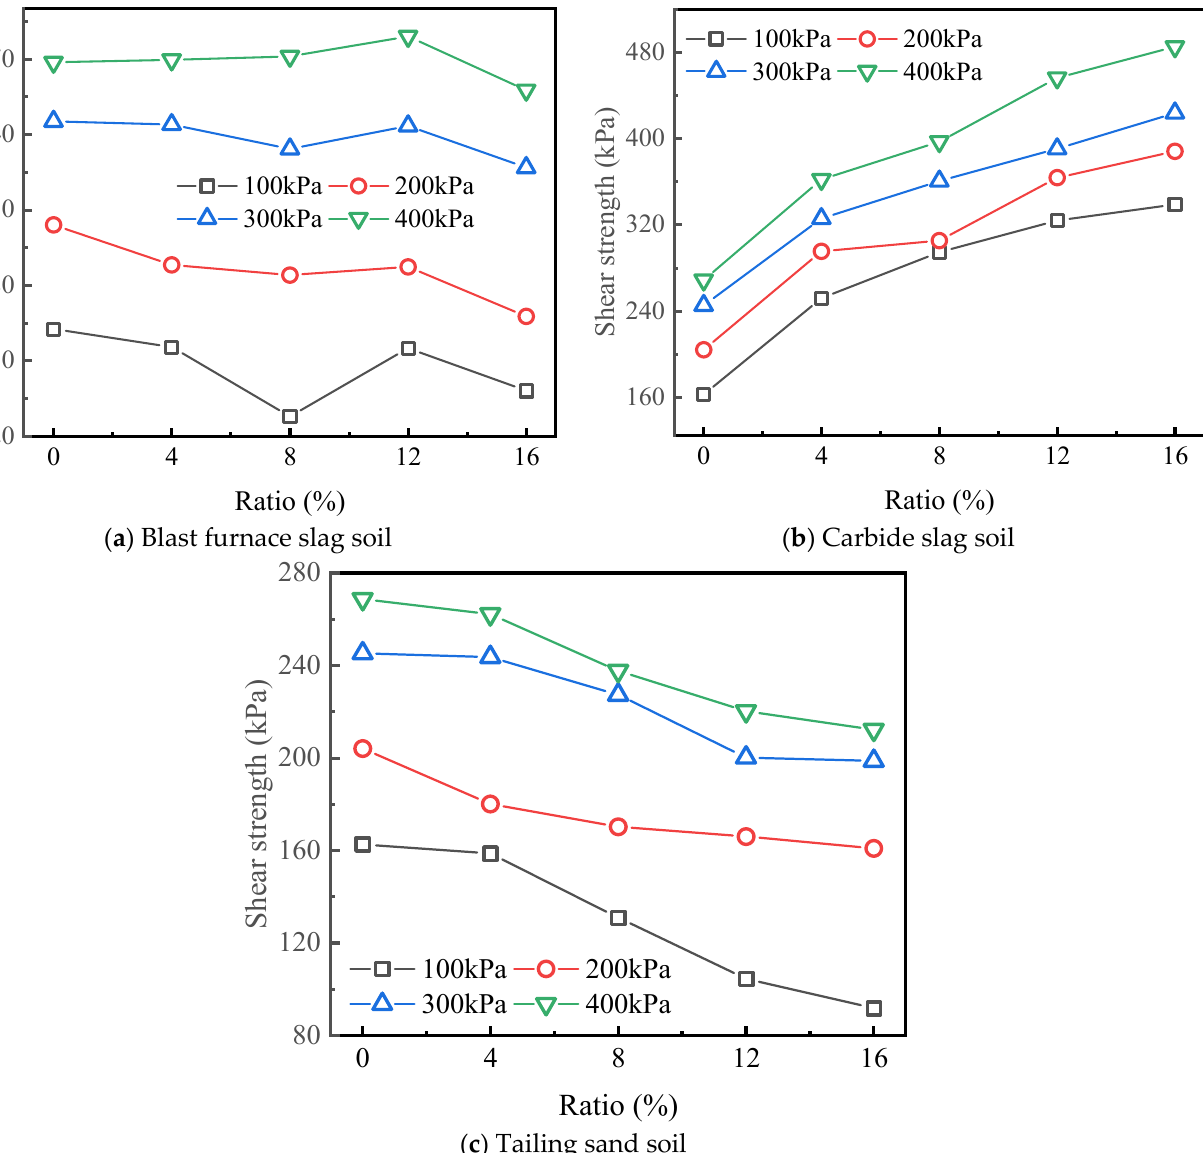
Figure 6. Change curves of shear strength of different waste residues soils.